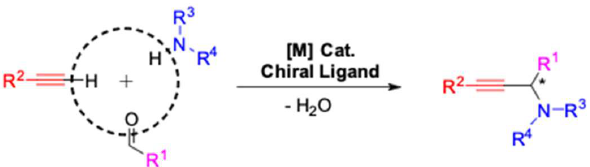
Figure 1. Asymmetric A 3 -coupling reaction.